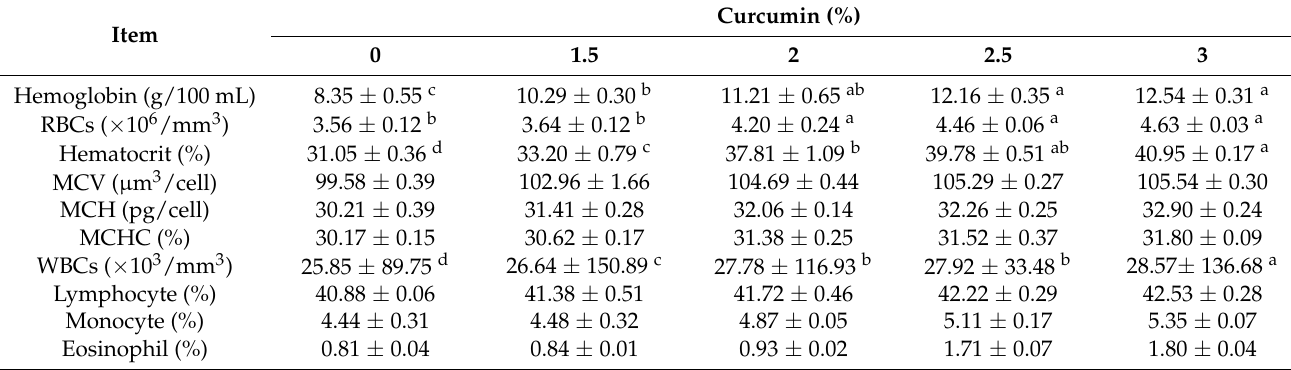
Table 4. Hematological parameters of Gilthead seabream fed varying levels of dietary curcumin for 150 days.